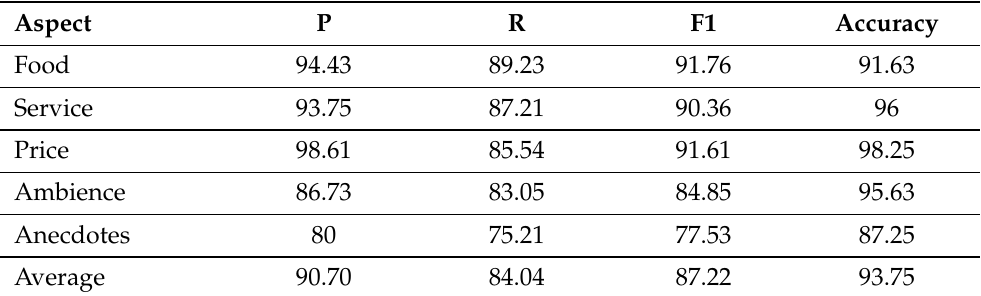
Table 4. Evaluation of the aspect detection module.